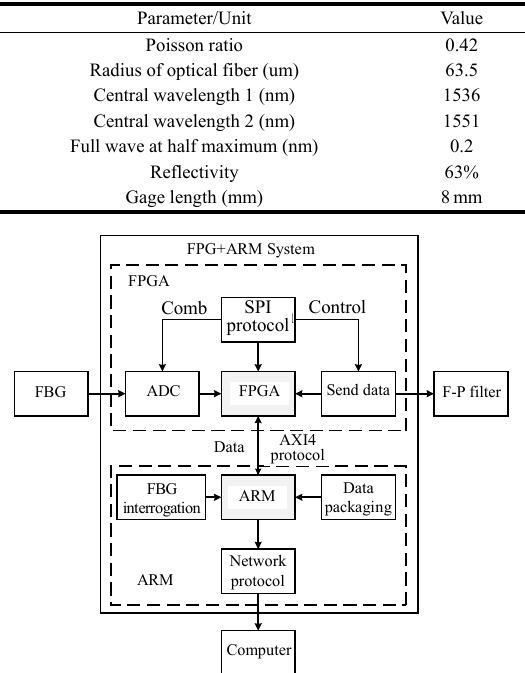
Table 1 Properties of FBG sensors.